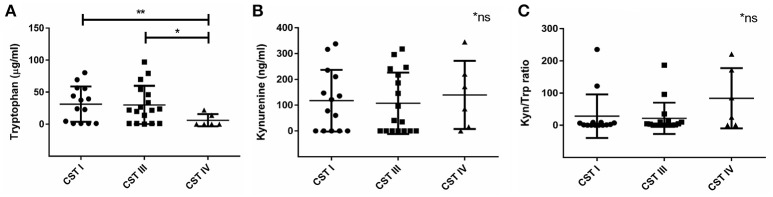
Vaginal tryptophan and kynurenine levels in women according to their CST. (A) Tryptophan (μg/ml), (B) kynurenine (ng/ml), and (C) Kynurenine/tryptophan ratio, in women with CST I (n = 14), III (n = 17) and IV (n = 6). Women with CST IV had significantly lower levels of tryptophan in compare to women with CST I (**p = 0.0058) and III (*p = 0.0126), using Mann-Whitney test. Data are presented as mean ± SD.